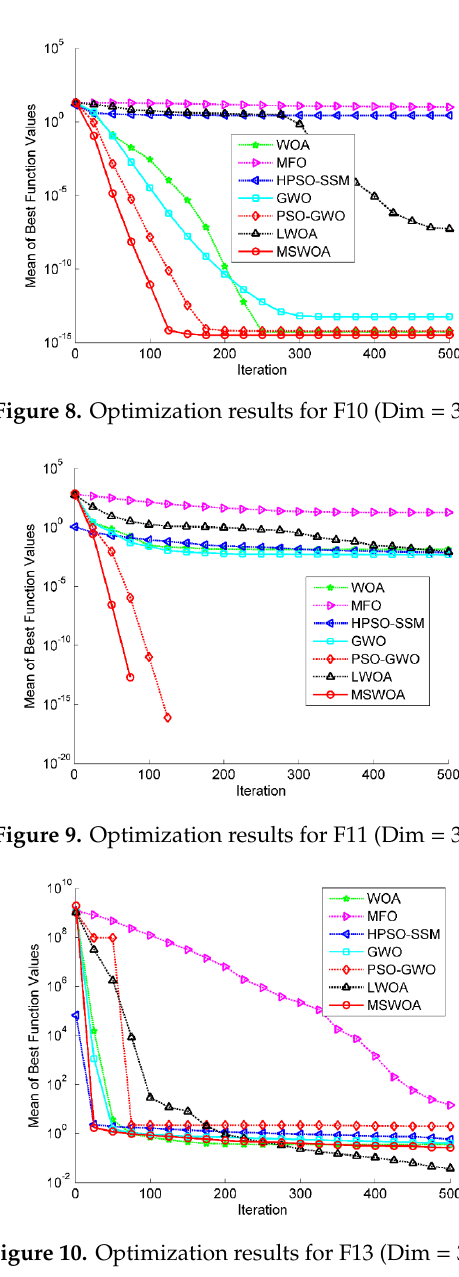
Figure 10. Optimization results for F13 (Dim = 30).